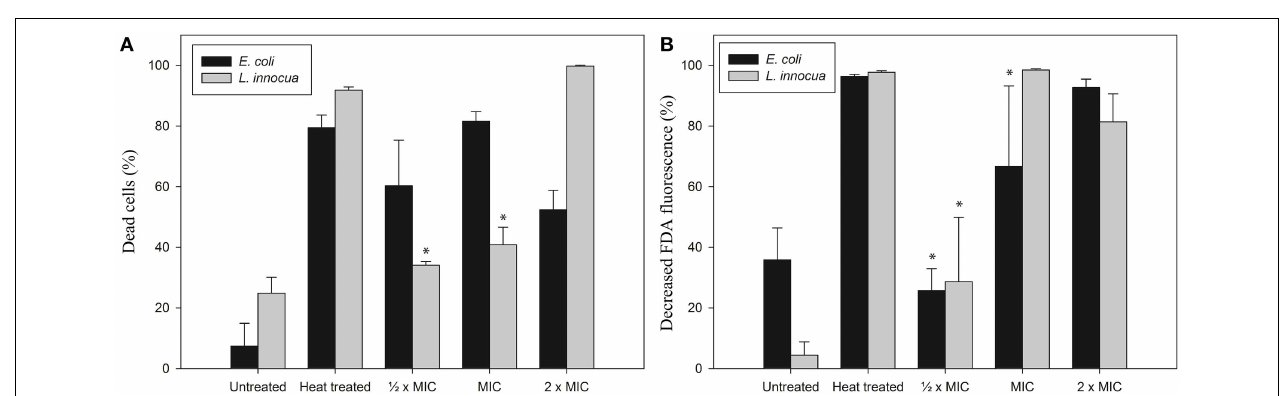
followed by incubation for 30min at 37 ◦ C. Cells were harvested and resuspended in MES-buffer before PI staining, except a control with no-stain. Cells with damaged membranes (A) or inactive esterases (B) were stained with PI or FDA, respectively. Asterisk indicates no statistical significant difference from untreated sample. Error bars = SD ( n = 3